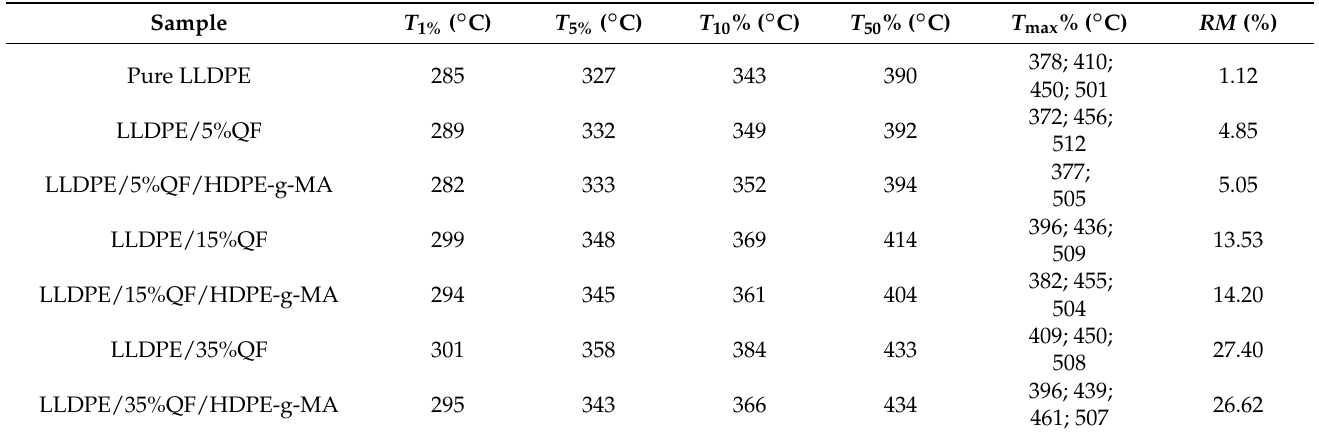
Table 3. Thermogravimetric analysis data for LLDPE/QF